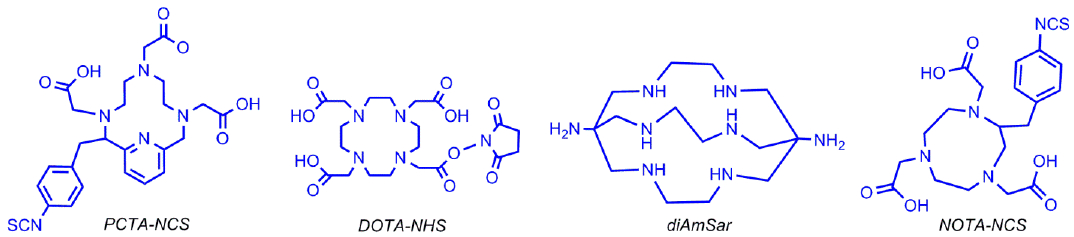
64 Cu to Figure 15. Chelator structures used to conjugate 64 Cu to biomolecules. Figure 15. Chelator structures used to conjugate Figure 15. Chelator structures used to conjugate 64 Cu to biomolecules.